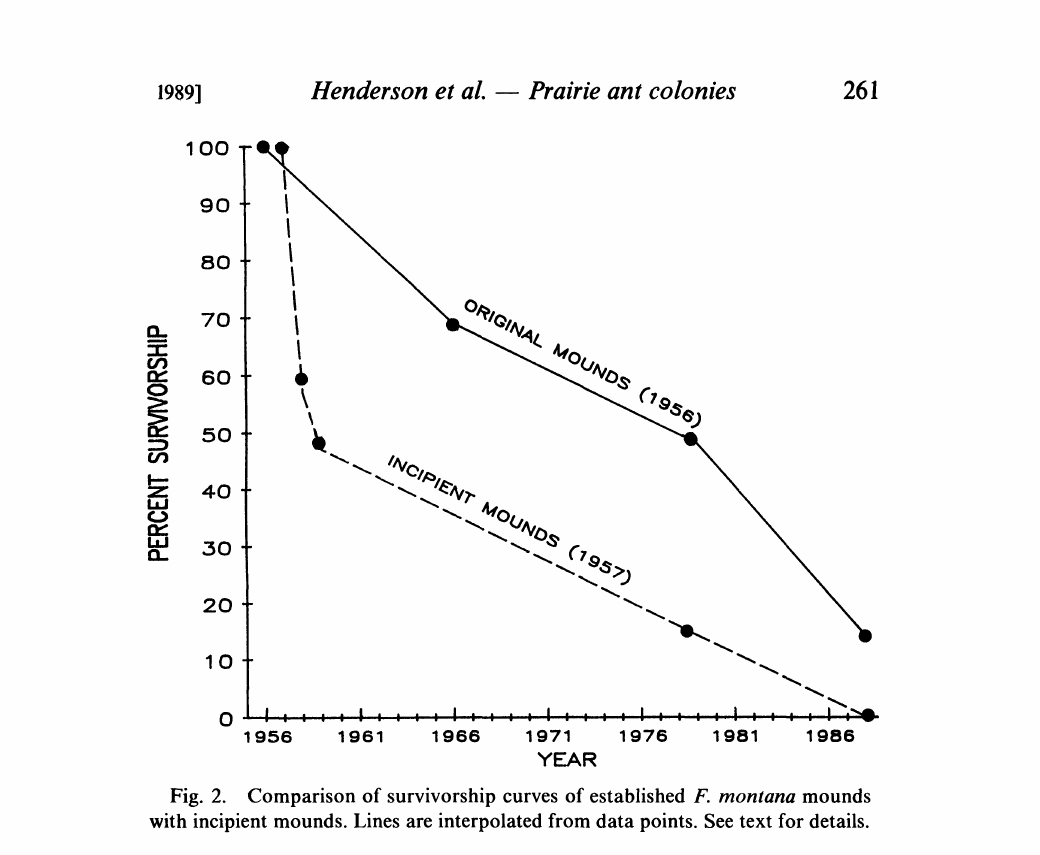
Fig. 2. Comparison of survivorship curves of established F. montana mounds with incipient mounds. Lines are interpolated from data points. See text for